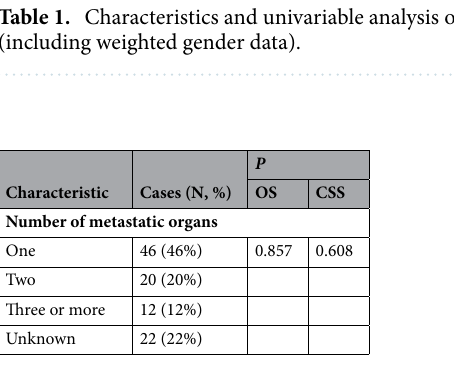
Table 2. Characteristics and univariable analysis of the number of metastatic organs on OS and CSS.